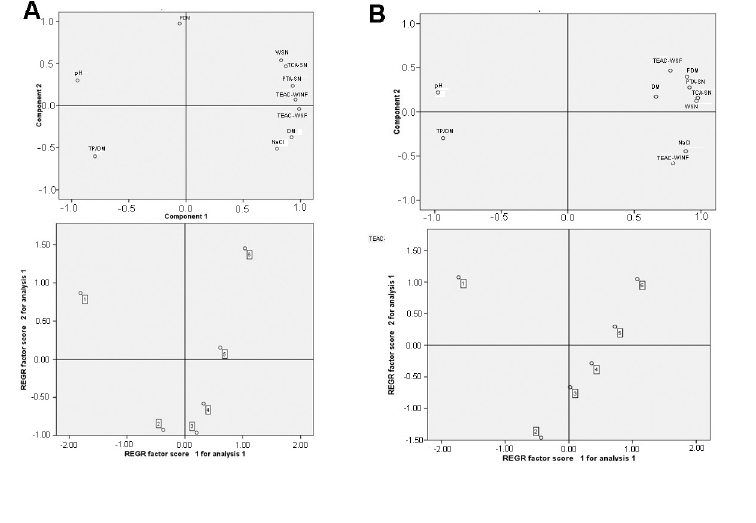
Figure 3. Principal component analysis (PCA) of experimental white-brined goat ( A ) and cow’s milk cheeses ( B ); PC1 × PC2, of parameters (a) and samples (b), as given in Tables 1 and 2. Sample 1—fresh cheese; samples 2-6—cheeses ripened for 10, 20, 30, 40, and 50 days, respectively.